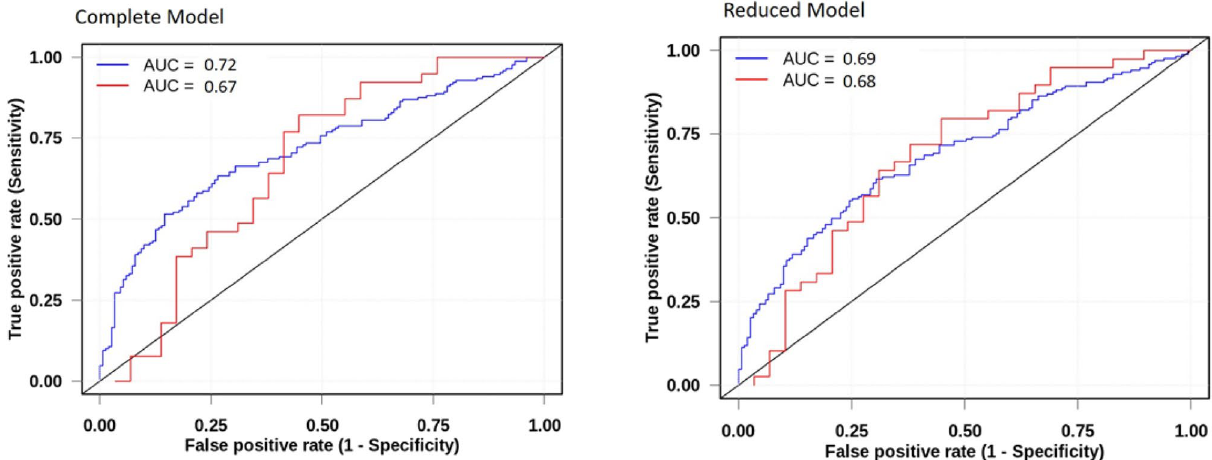
Figure 3. Comparison between the Complete and Reduced Models to predict Gram-negative bacteremia. AUC = area under curve. Complete Model = Monocytes%, Bands (/mm 3 ), p50 (mmHg); Mean Corpuscular Haemoglobin (CHCM) (g/dl), Bands%, Age, Monocytes (/mm 3 ), Hydrogen potential (pH), total CO 2 (mmol/L), Methaemoglobin (%), ionized Calcium (iCa—mg/dL), Lactate (mmol/L), platelet count (PLT—10 3 /mm 3 ), Creatinine (mg/dl), Mean corpuscular haemoglobin (MCH—fl) and Red blood cell count (RBC—millions/μL). Reduced Model = PLT, creatinine, MCH and RBC. Blue: Validation (n = 320) . Red: Prediction using the 2019 database (n = 69)